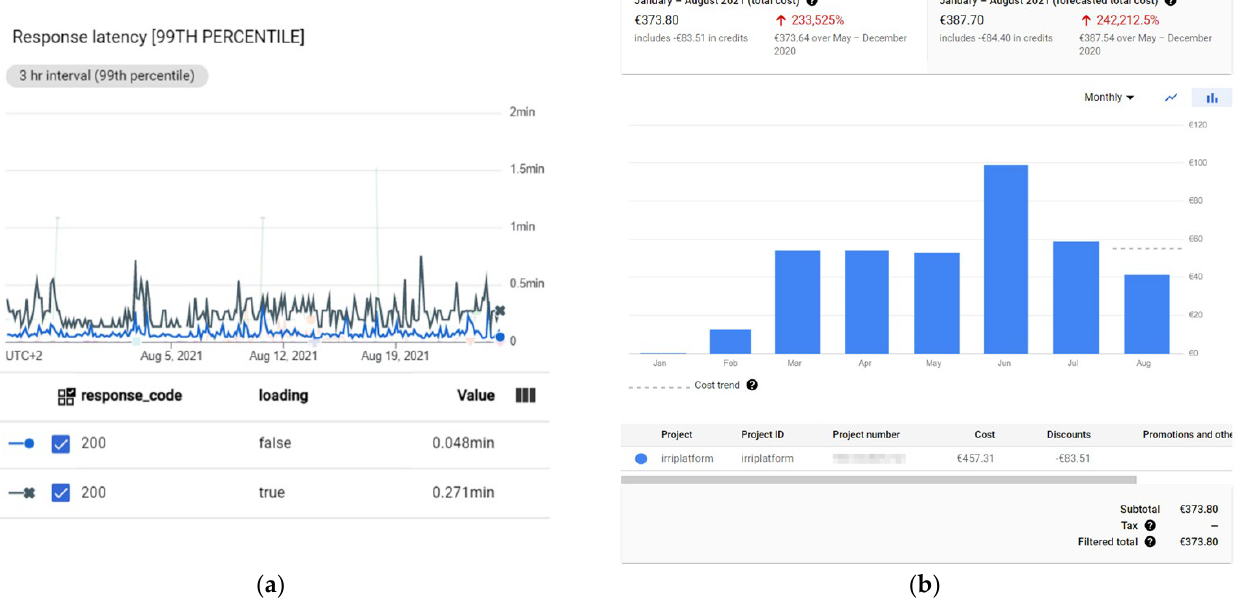
Figure 17. Statistics that summarize the response latency and the billing results. ( a ) Response latency for requests with a response code of 200. ( b ) Billing information calculated monthly.